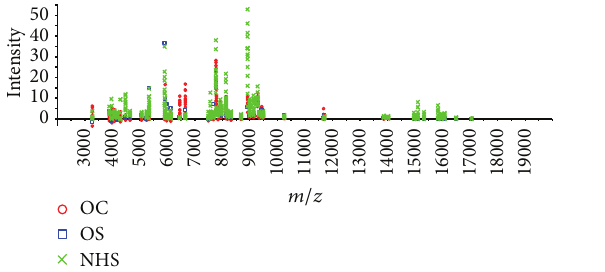
Figure 3: Classification tree topology for GROUP. Node 1